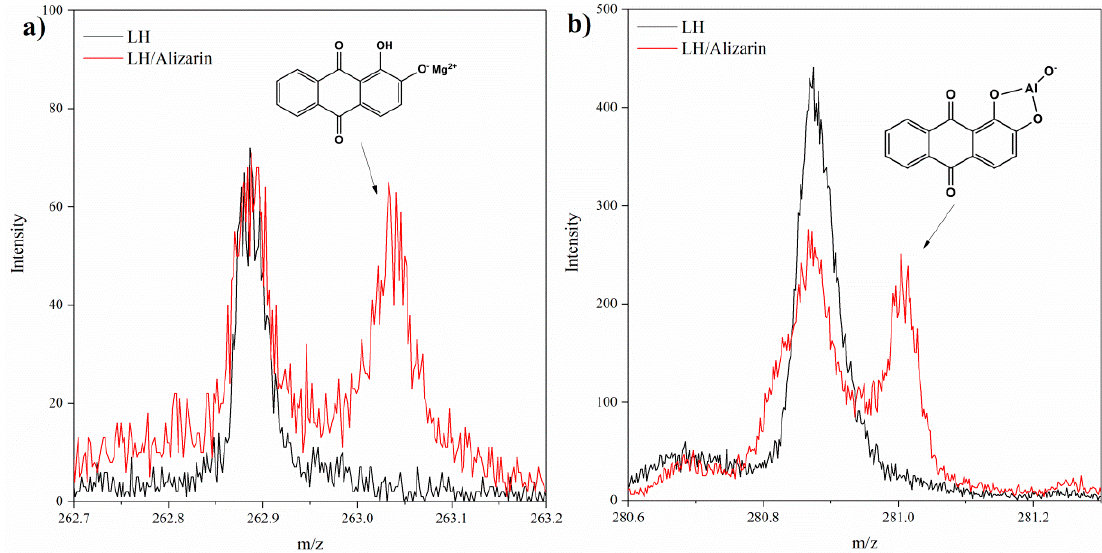
Figure 1. Positive ( a ) and negative ( b ) TOF-SIMS spectra of LH and LH/Alizarin (10%) samples.